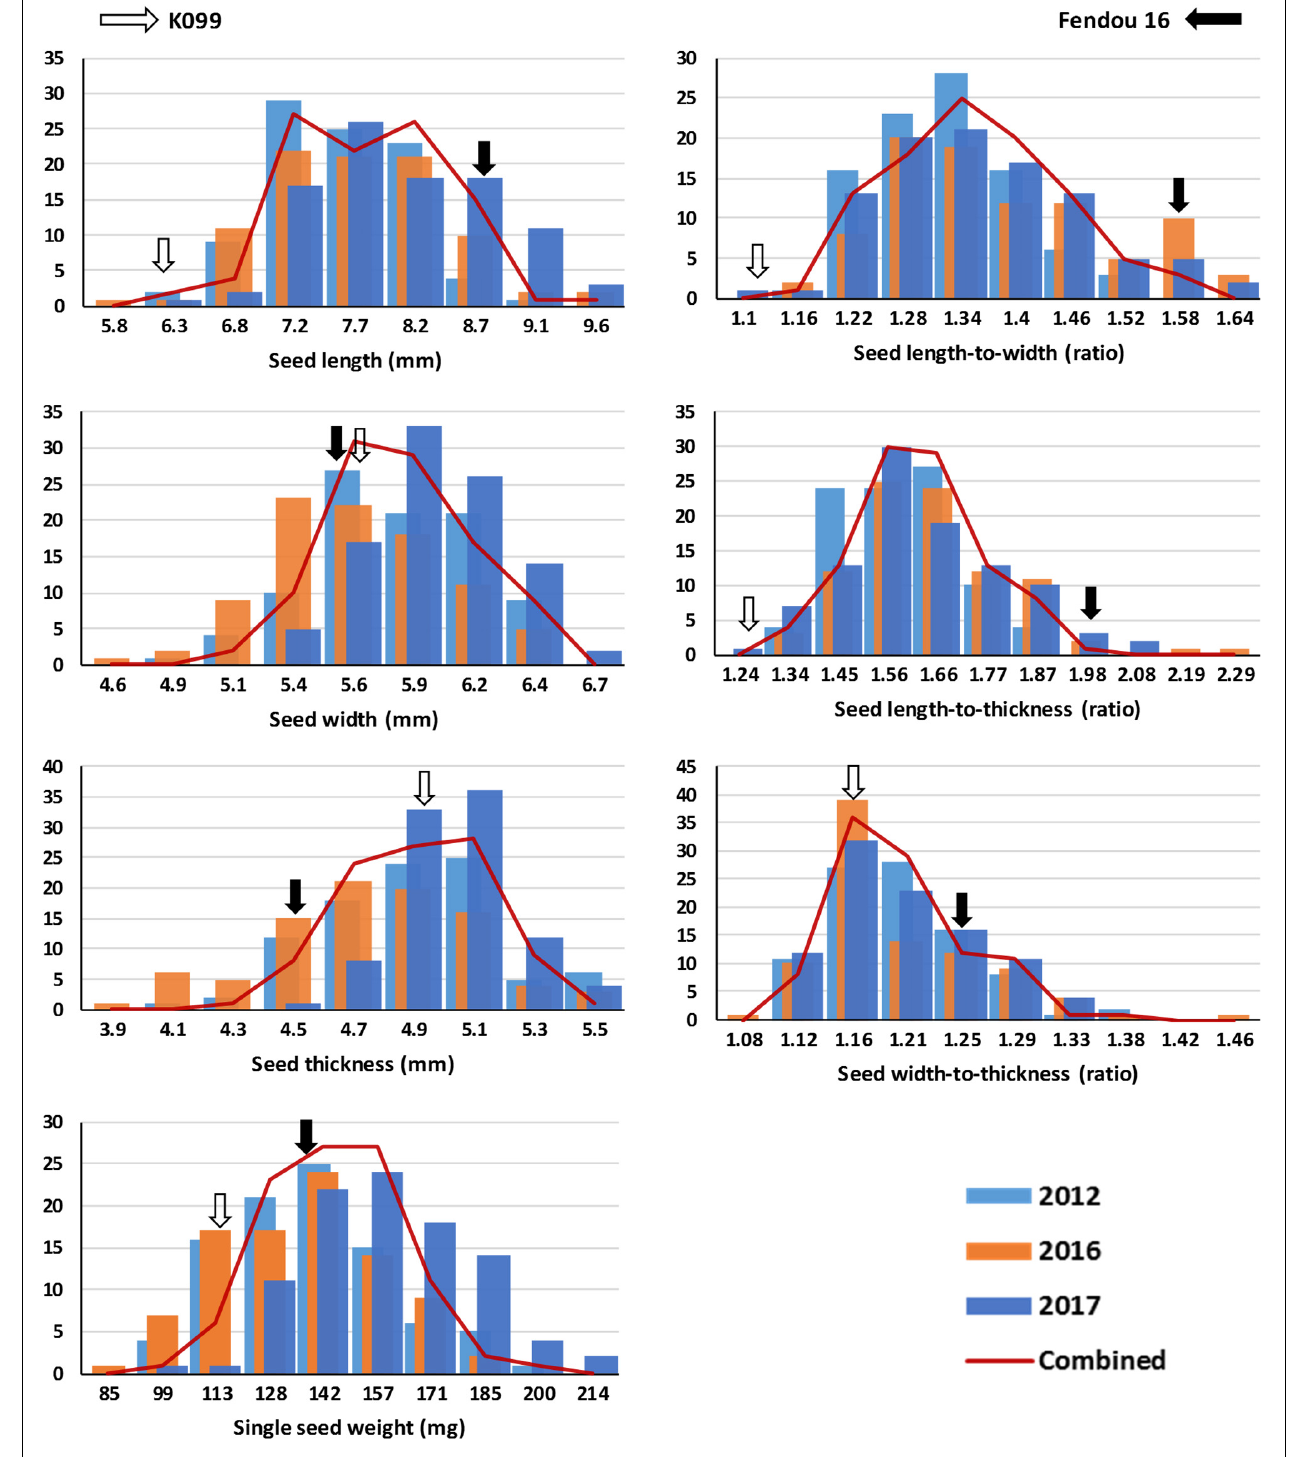
FIGURE 1 | Frequency distribution of seed length (SL), seed width (SW), seed thickness (ST), single seed weight (SSW), and ratios of seed length-to-width (SLW), seed length-to-thickness (SLT), and seed width-to-thickness (SWT) in K099 × Fendou 16 recombinant inbred line (RIL) population ( n = 94) grown across multiple years (2012, 2016, and 2017). Trend lines show the average of 3-year environments data. Arrows represent the mean value of the corresponding parent genotype. The horizontal and vertical axes represent the trait value and number of RILs, respectively.